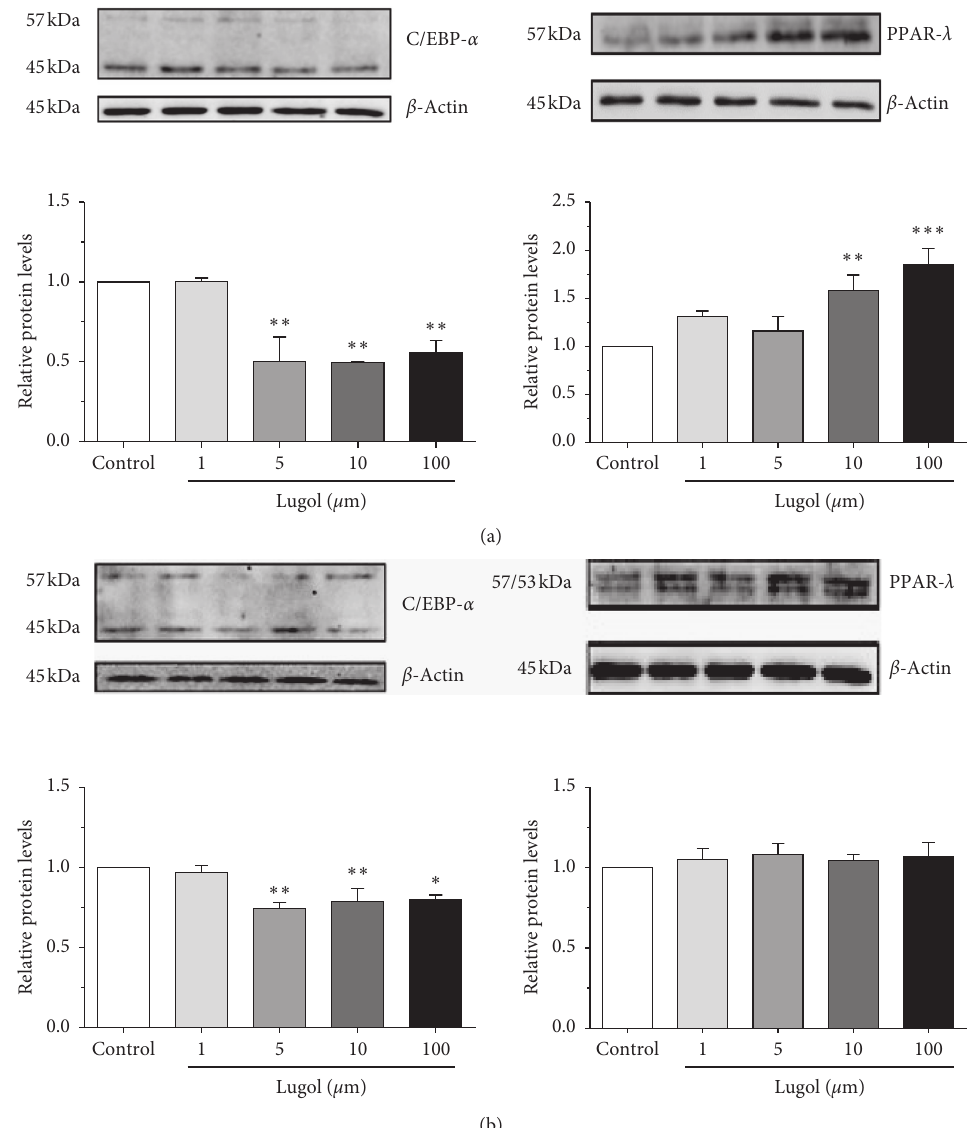
Figure 3: The effect of lugol on C/EBP- α and PPAR- c protein expression in mature 3T3-L1 adipocytes. The cells were treated with 0, 1, 10, and 100 µ m of lugol for 30min and 6h and lysed in RIPA buffer for 1h. The supernatant was subjected to SDS-PAGE. The blots were blocked and then were incubated with the primary and HRP-conjugated secondary antibodies. Detection was performed according to the enhanced chemiluminescence protocol. (a) 30min after lugol treatment; (b) 6h after lugol treatment. All quantitative data are mean ± SD ( n � 3/ group). ∗ P < 0 . 05 and ∗∗ P < 0 . 01 vs. control (vehicle)